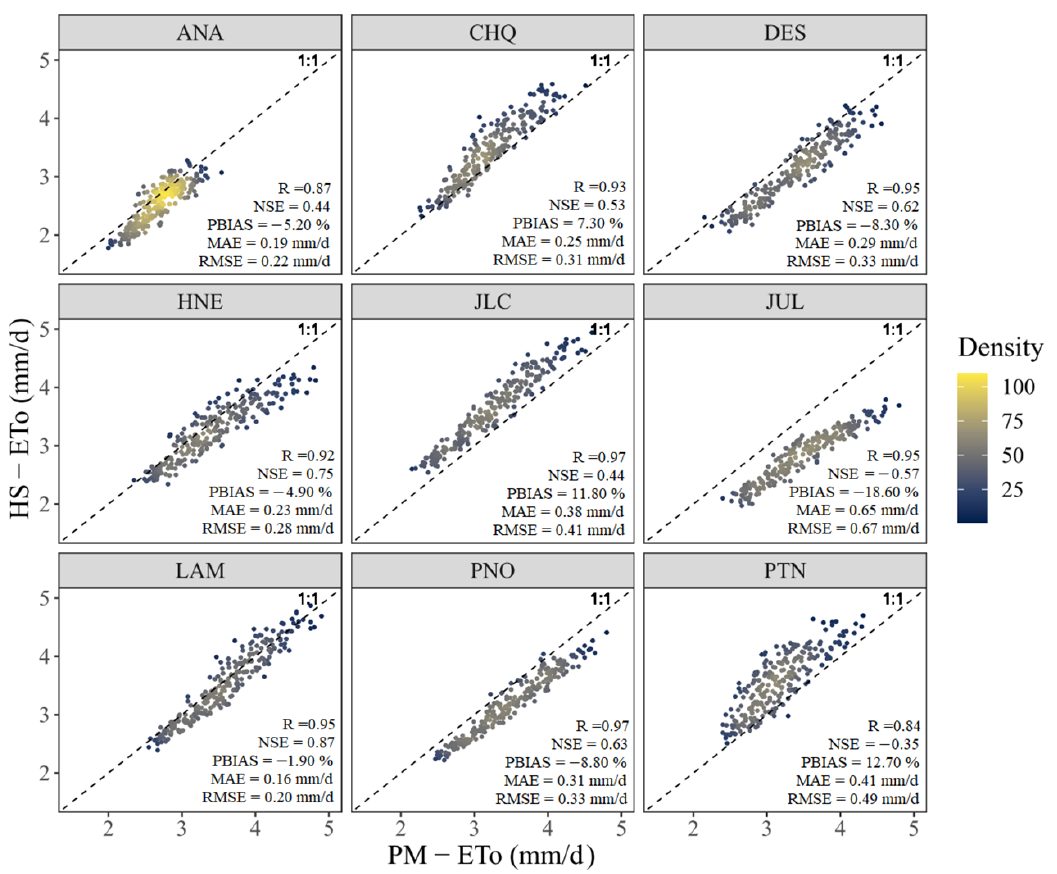
Figure 4. Scatter diagrams between values of ETo by the PM method versus original HS at the weather stations.